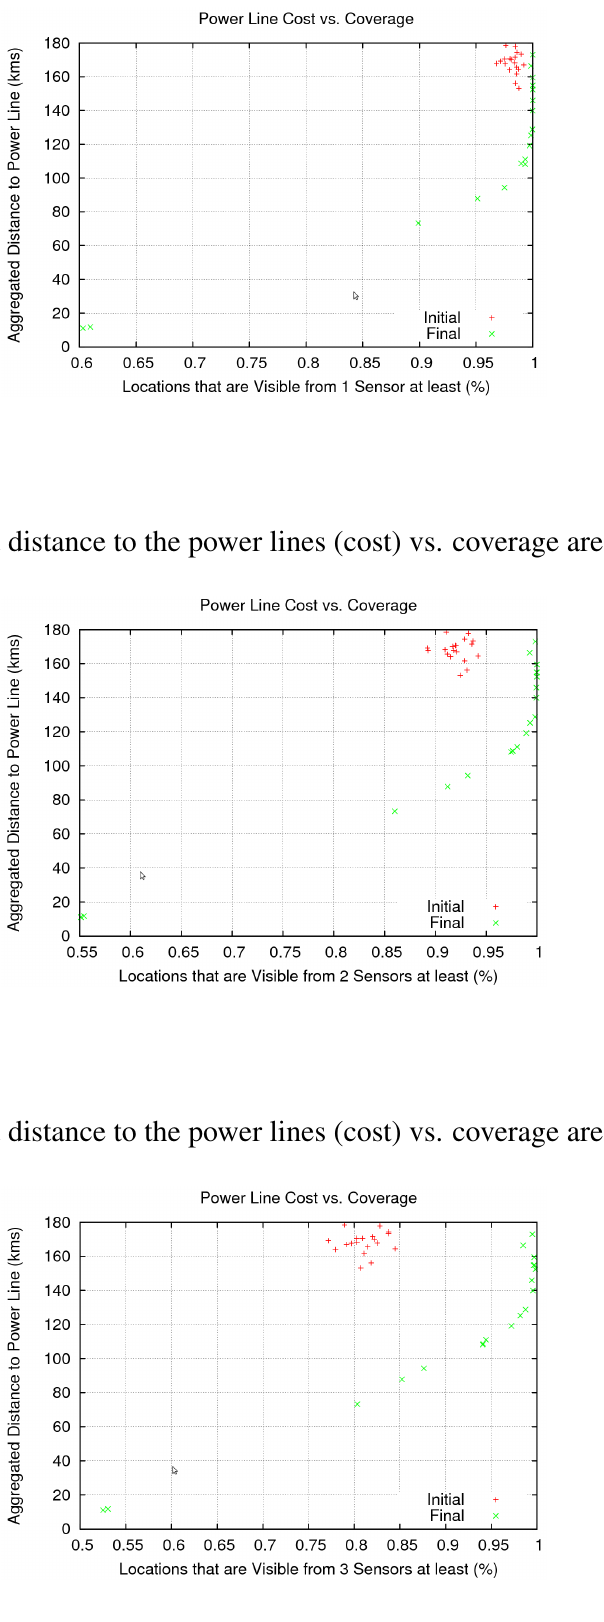
Figure 6. Aggregated distance to the power lines (cost) vs. coverage area with V ( x ) ≥ 1 .